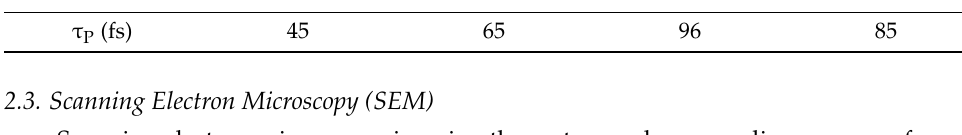
Table 1. Calculated final pulse duration ( τ P ) after passing through the liquid.